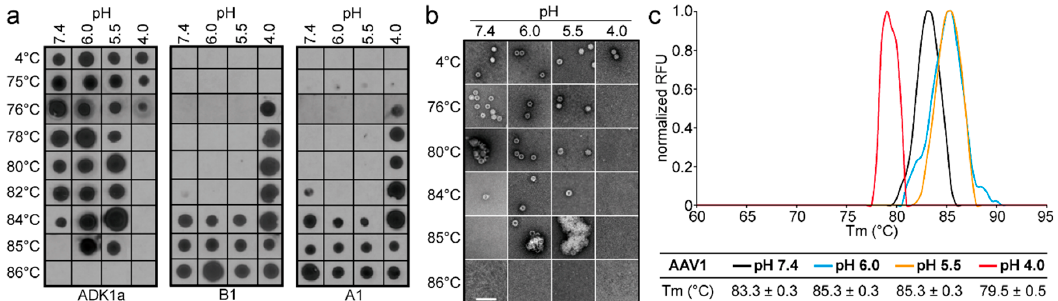
Figure 1. Adeno-associated virus 1 (AAV1) stability analysis. ( a ) Dot immunoblots of AAV1-green fluorescent protein (GFP) vectors at different pHs representative of physiological (7.4), early endosomal (6.0), late endosomal (5.5), and lysosomal (4.0) conditions. The virus was heat-shocked at the temperature indicated and blotted for intact capsids (ADK1a), denatured capsids (B1), and the accessibility of VP1u (A1). ( b ) Negative-stain electron microscopy (EM) of AAV1-GFP vectors treated as in ( a ). Scale bar: 100 nm. ( c ) T m of AAV1-VLPs determined by DSF at the pH conditions used in ( a ) and ( b ). A thermal profile for each pH condition is shown as normalized relative fluorescence units (RFUs) versus temperature (in °C). All experiments were performed in triplicate.